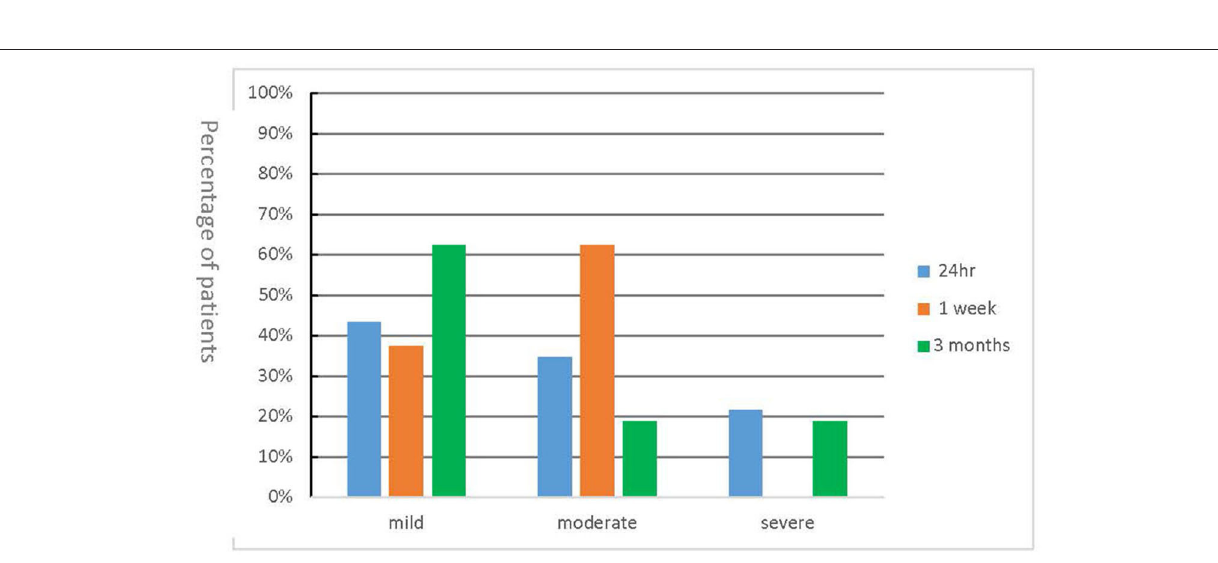
FIGURE 3 | Intensity of post-operative pain. Patients were contacted via phone call at 24 h, 1 week, and 3 months after the procedure and asked to rate their pain intensity on a 11-point numerical